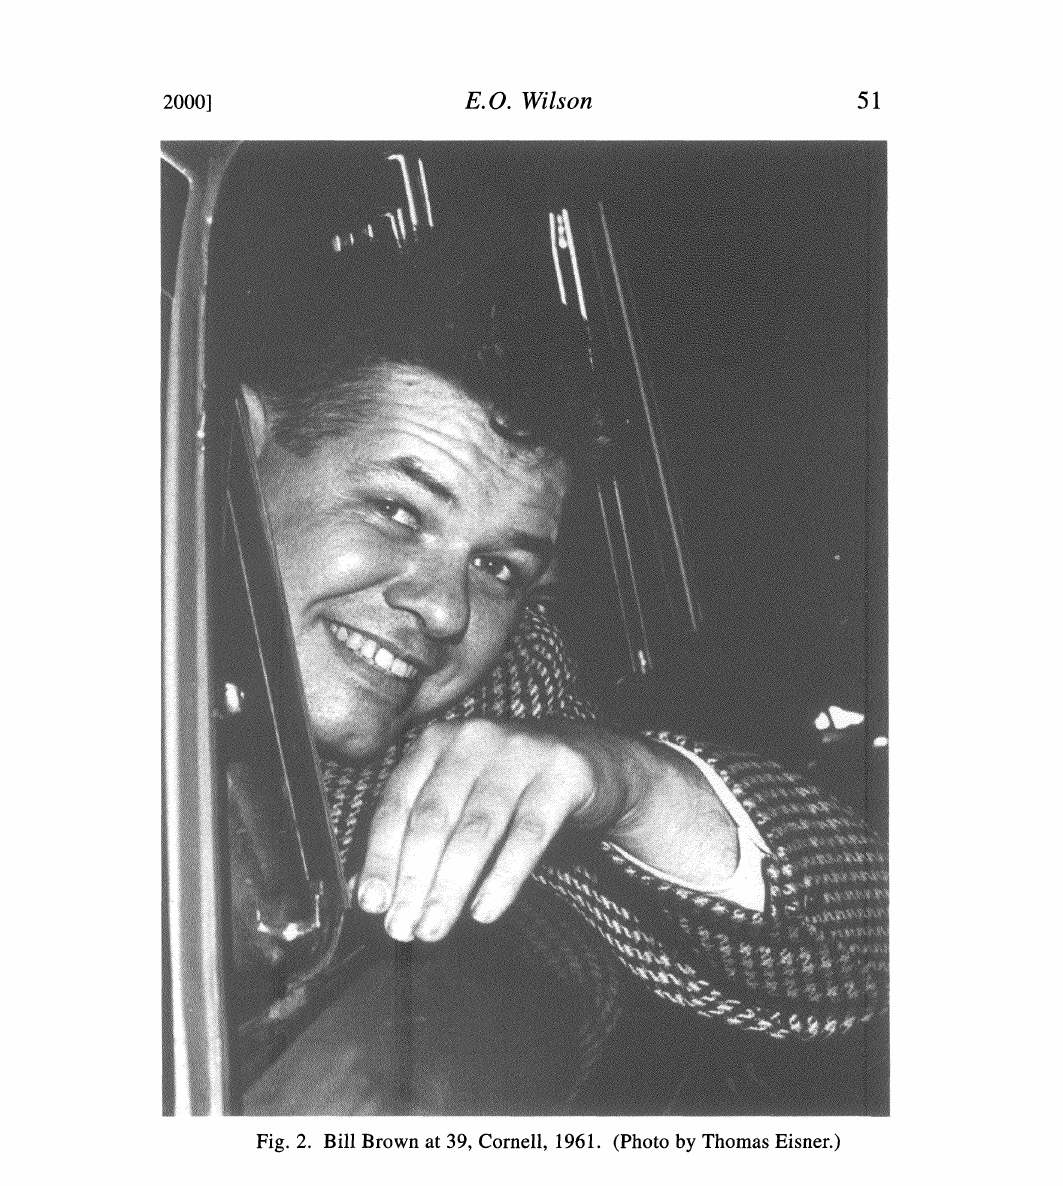
Fig. 2. Bill Brown at 39, Cornell, 1961. (Photo by Thomas